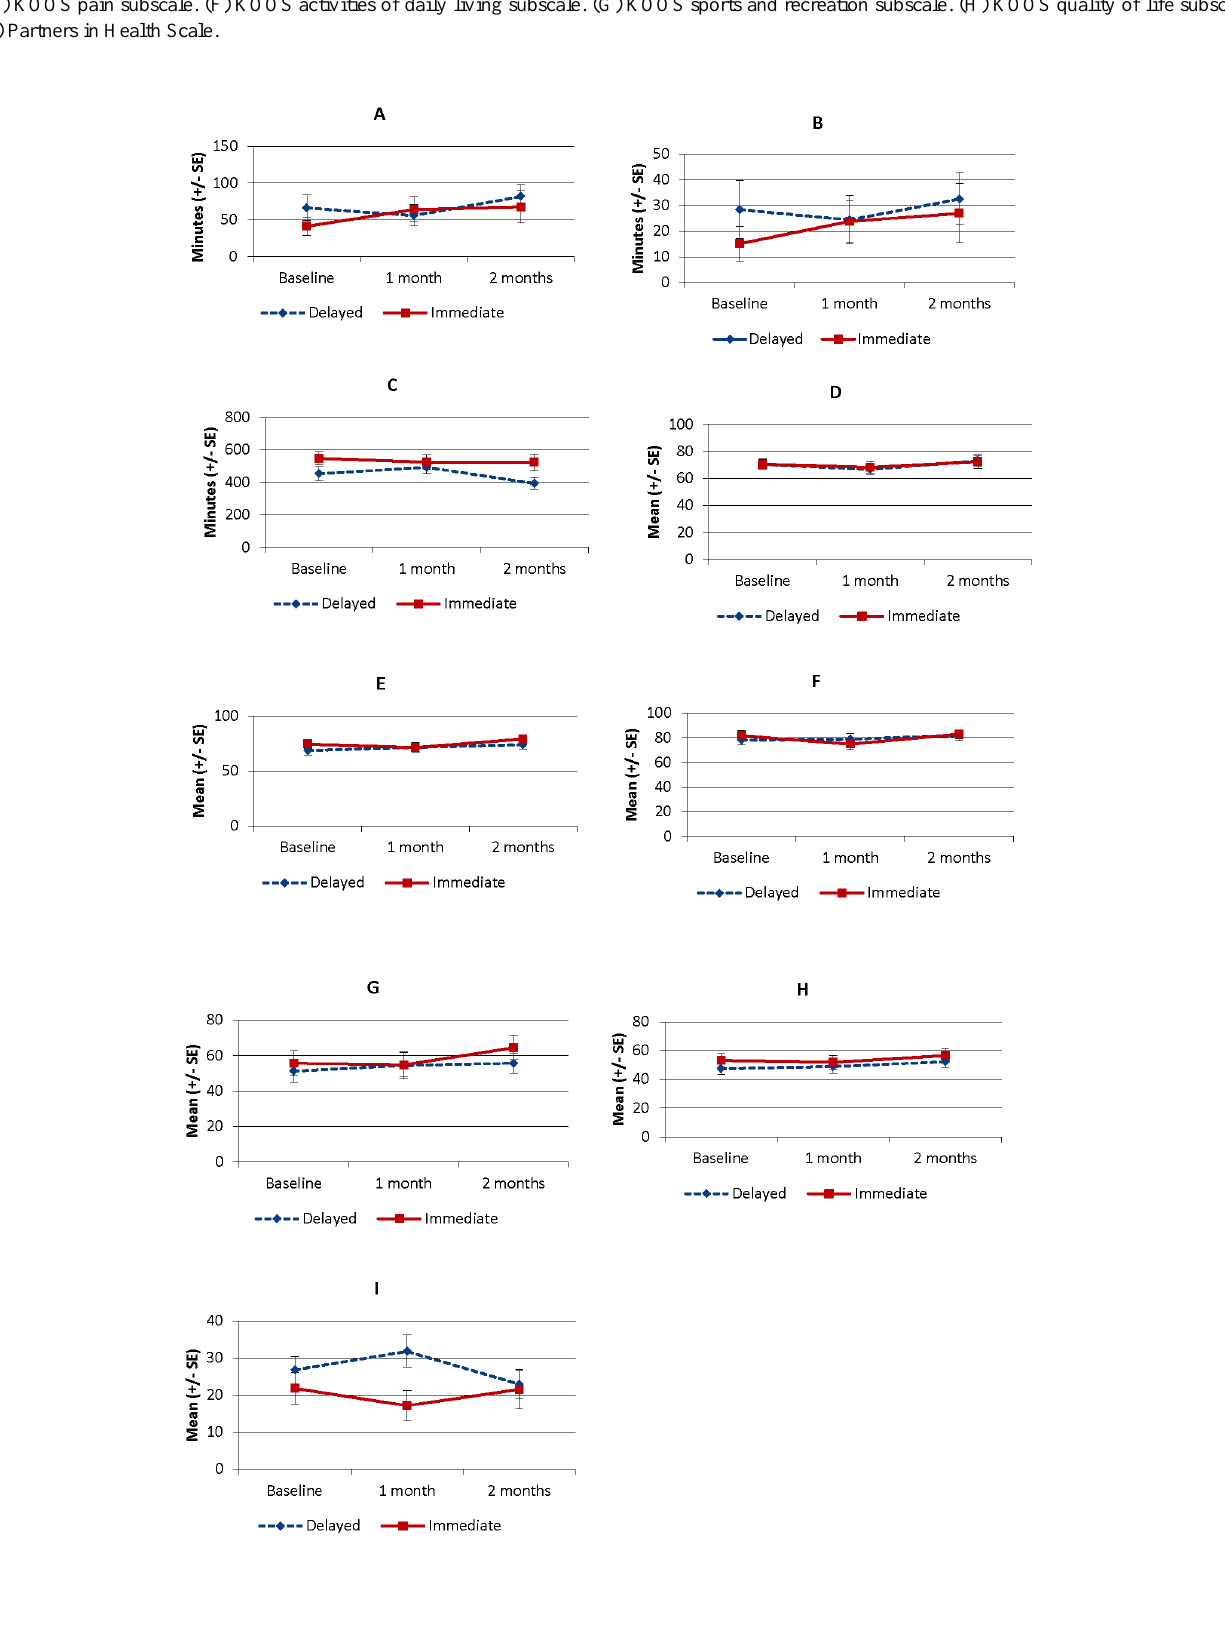
Figure 2. Results of outcome measures. (A) Bouted moderate to vigorous physical activity ( ≥ 3 metabolic equivalent tasks [METs]). (B) Bouted moderate to vigorous physical activity ( ≥ 4 METs). (C) Bouted sedentary time. (D) Knee Injury and Osteoarthritis Outcome Score (KOOS) symptoms subscale. (E) KOOS pain subscale. (F) KOOS activities of daily living subscale. (G) KOOS sports and recreation subscale. (H) KOOS quality of life subscale. (I) Partners in Health